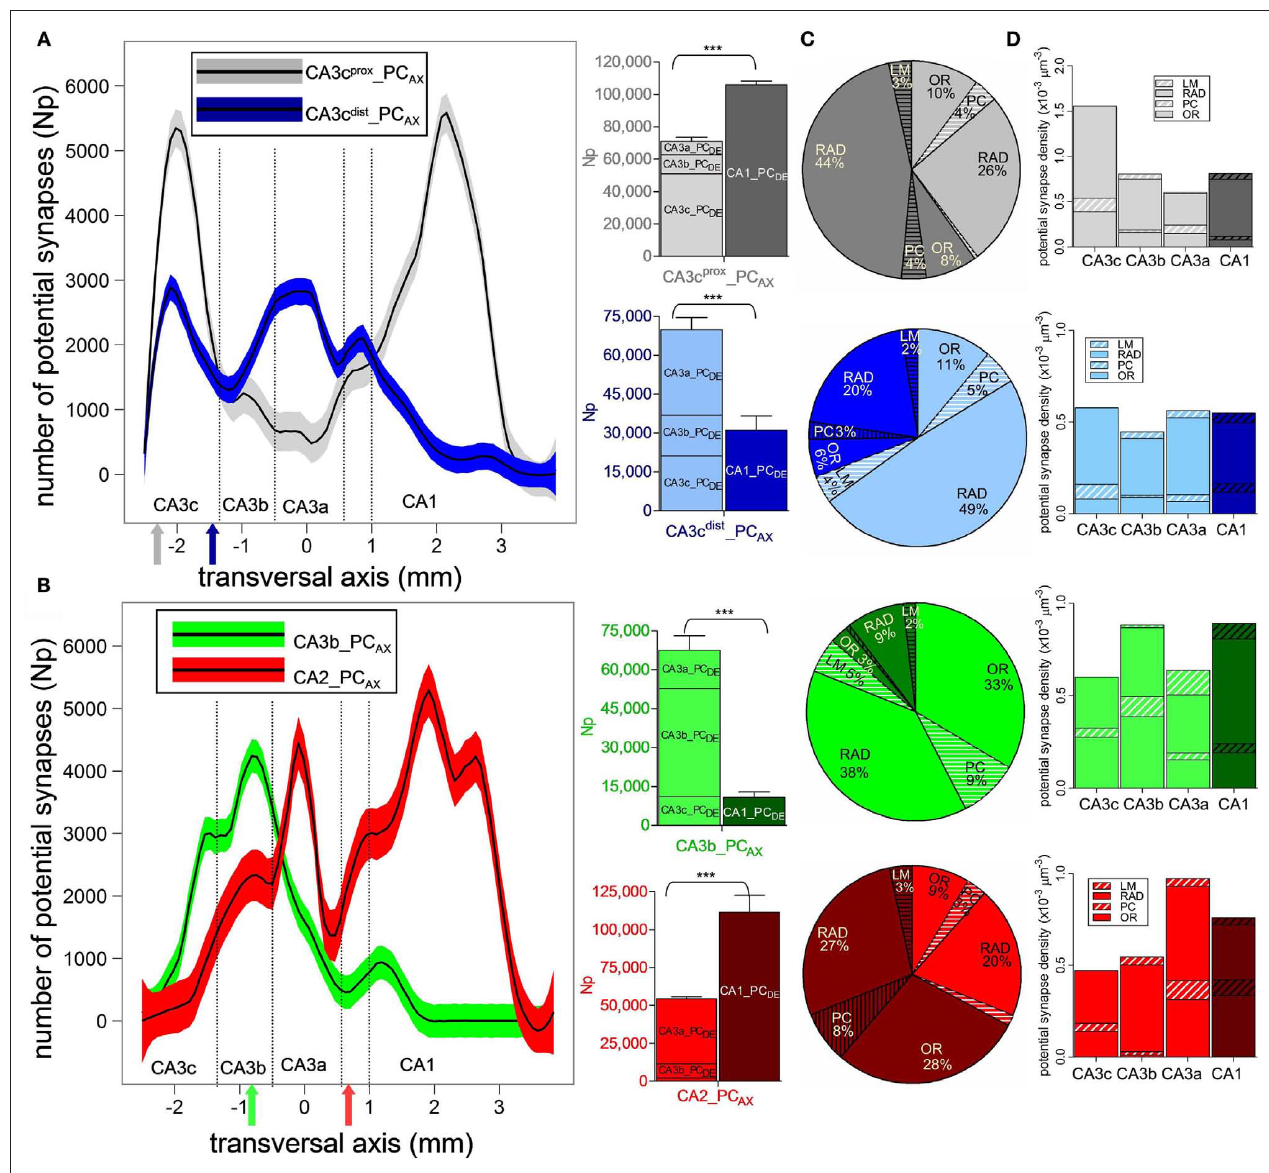
the total counts in each CA3 sub-region and in CA1. (C) Proportion of Figure 4 | Sub-region and layer specificity of pyramidal cell potential potential contacts in CA3 (light) and CA1 (dark) layers. The layers not connectivity. (A,B) Potential synapse distributions along the transversal axis primarily targeted by these axons (PC and LM) are striped. (D) Density of for CA3c prox _PC (A, gray), CA3c dist _PC (A, blue), CA3b_PC (B, green), AX AX AX potential synapses in the layers of each CA3 sub-region (light) and and CA2_PC (B, red). The solid colored arrows indicate the soma AX transversal positions. For each of the four axonal arbors, bar plots summarize